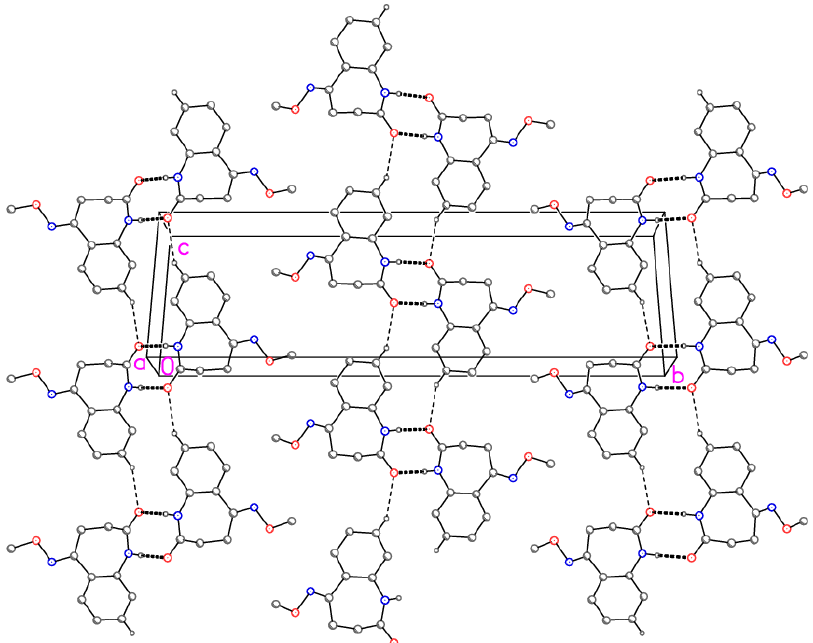
Figure 2. Packing diagram of compound 4 viewed perpendicular to (–1 0 1). Dashed lines represent classical (thick) or “weak” (thin) hydrogen bonds. Hydrogen atoms not involved in hydrogen bonding are omitted for clarity.